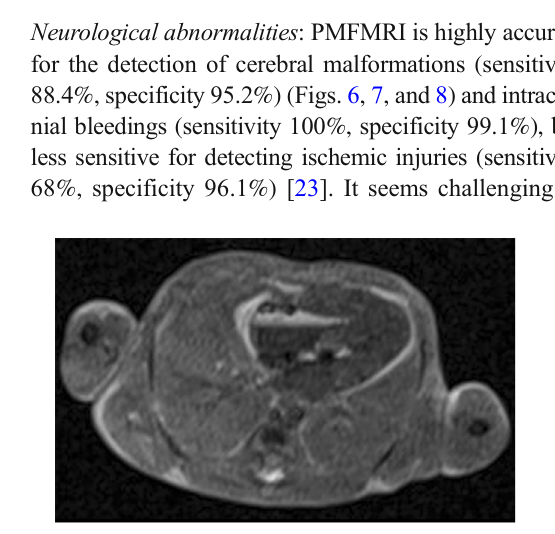
Fig.5 Axial T2-Wimage ofa 23 weeks fetus showing air and blood clots in the heart as a physiological postmortem change. It also shows the normal gray appearance of fetal lungs that have not been